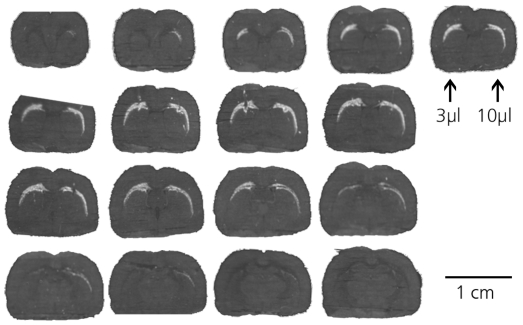
Distribution of adenoviral transgene expression in rat corpus callosum and external capsule.3 µl or 10 µl of AdGFP containing 8.4*106 iu was infused into the external capsule. 30 µm sections of one representative rat are shown. Left side of images: 3 µl infusion, right side: 10 µl infusion. Slides are arranged in rostrocaudal (from upper left to lower right) direction. GFP expression is extended when virus is infused in 10 µl compared to bolus, both in coronal and sagittal planes.